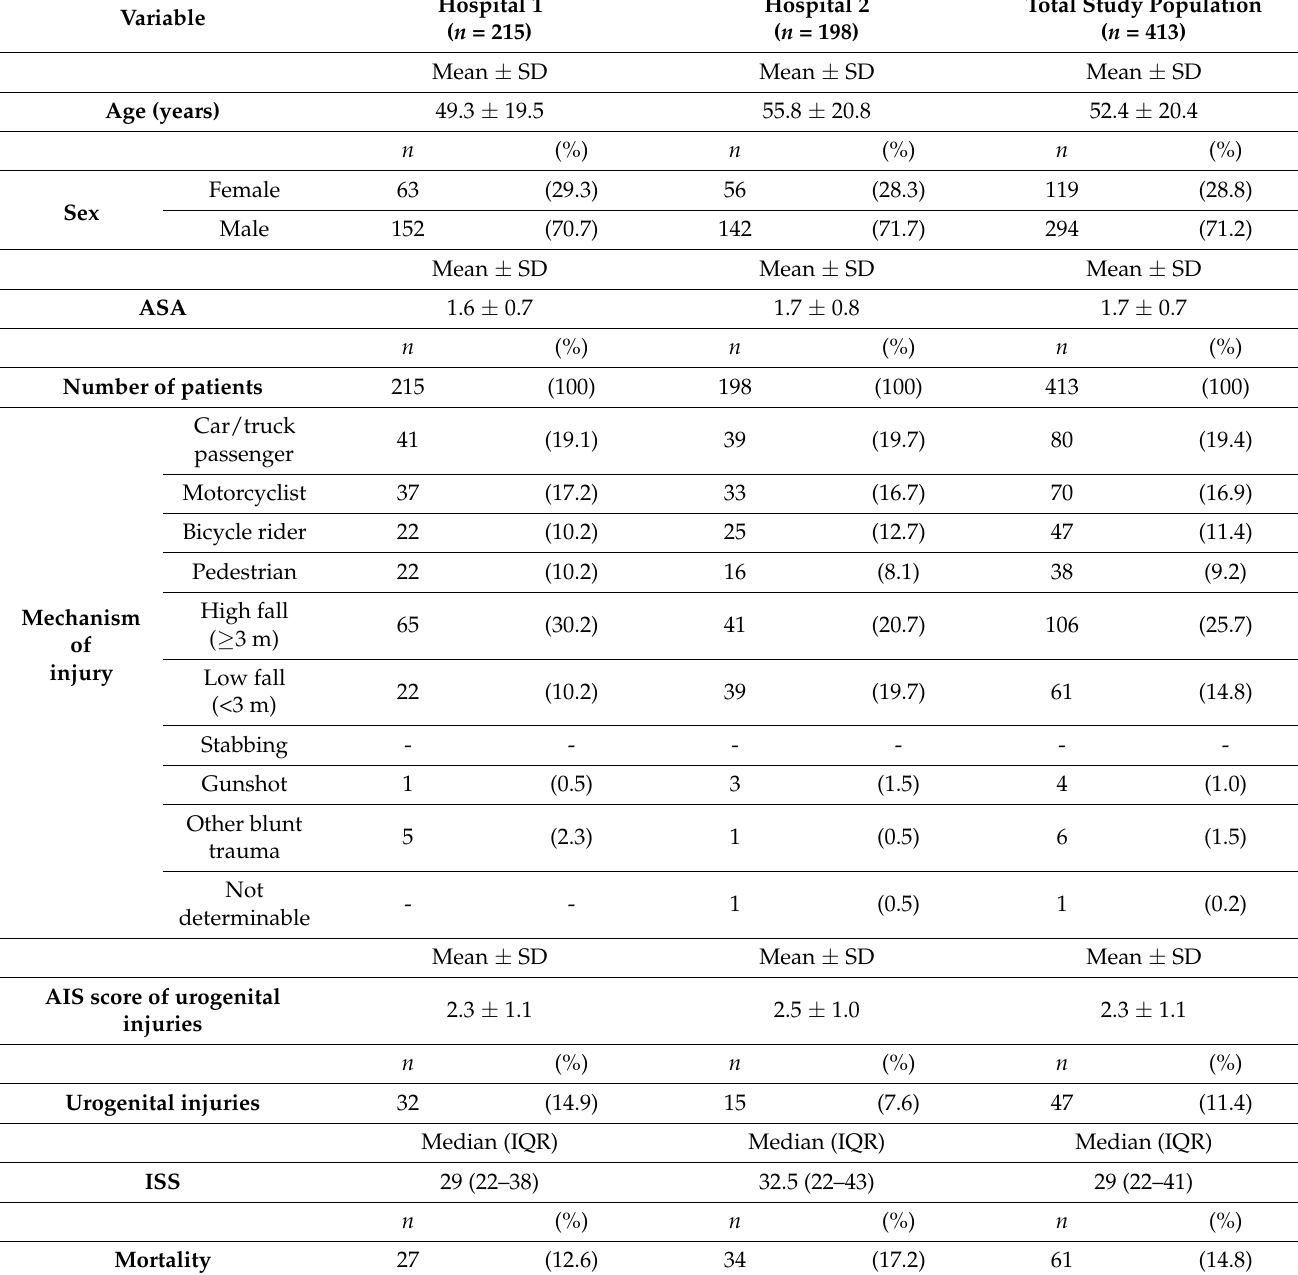
Table 1. Demographics and trauma specific data, comparison of participating